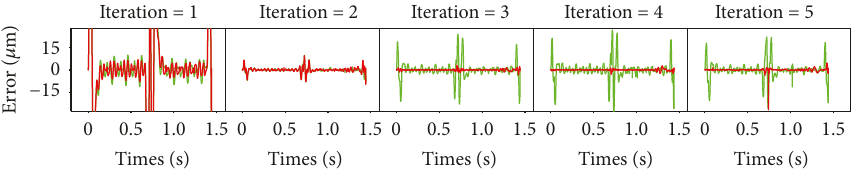
Figure 12: Tracking error in each iteration. Red frequency lines: proposed ILC algorithm in (21). Green frequency lines: existing ILC algorithm in